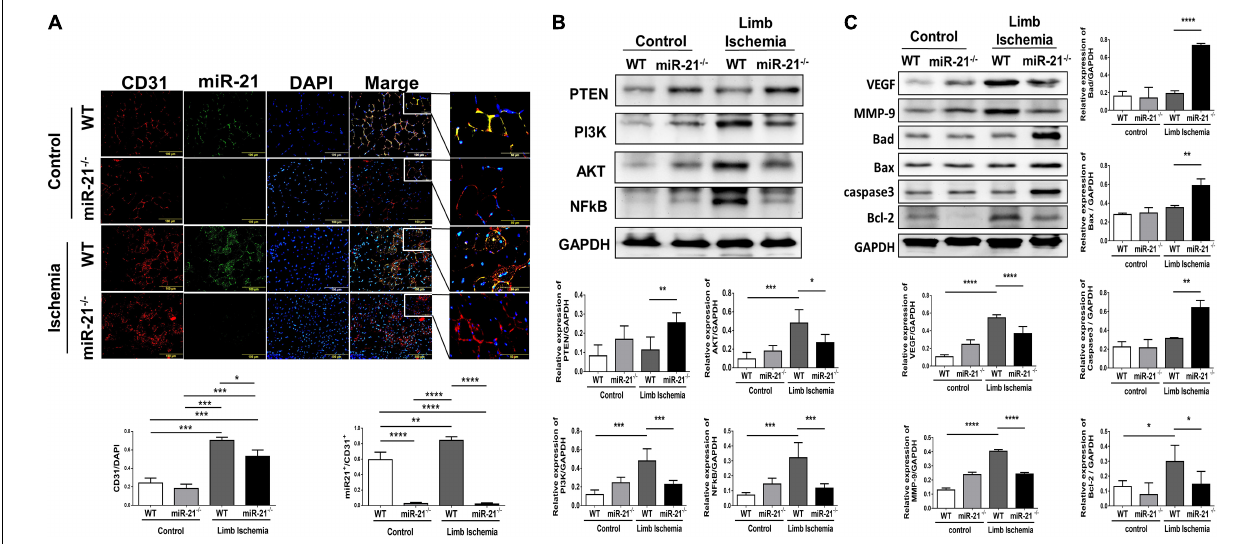
FIGURE 2 | Impaired capillary density, expression of angiogenesis-, proliferation-, and apoptosis-associated proteins in wild-type and microRNA-21 (miR-21) – / – mice post hindlimb ischemia surgery. (A) Representative images and quantification of CD31 immunostaining representing capillary density. miR-21 in situ hybridization indicated that miR-21 was mainly expressed in endothelial cells in wild-type mice after limb ischemic surgery. (B) Representative blots and quantification of PTEN, PI3K, AKT, NF κ B, VEGF, MMP9 and (C) apoptosis-associated protein expression in the ischemic limbs of wild-type and miR-21 – / – mice. The experiment was repeated in triplicate, * P < 0.05, ** P < 0.01, and *** P = 0.001, and **** P <